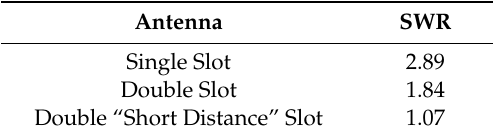
Table 2. Coaxial slot antenna standing wave ratio (SWR)